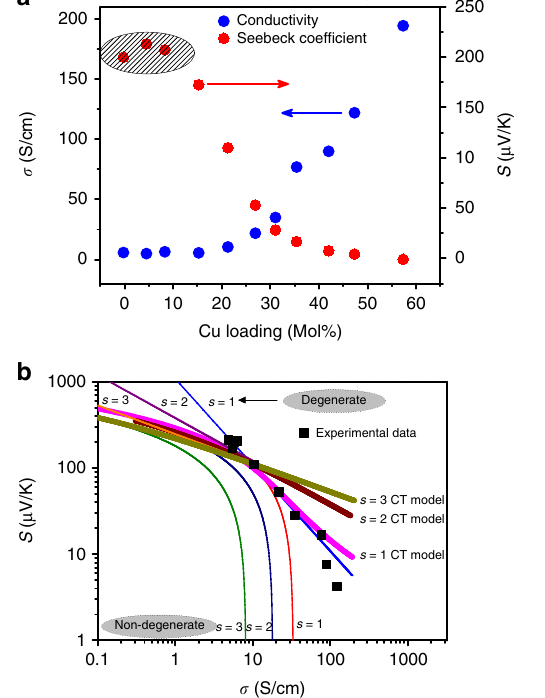
Fig. 3 Kang-Snyder transport model applied to the PEDOT:PSS-Te(Cu x ) hybrid system. a Electrical conductivity and Seebeck coef fi cient at room temperature of the PEDOT:PSS-Te(Cu x ) NW hybrid system as a function of copper loading [Adapted with permission from Zaia et. al., Nano Lett. 16 , 3352 (2016). Copyright (2016) American Chemical Society] 10 ( b ) The Kang-Snyder charge transport model with different energy-dependent scattering exponent, s, as described in the main text is shown. Our experimental data lie on the s = 1 curve, similar to pure PEDOT NATURE COMMUNICATIONS| (2018) 9:5347